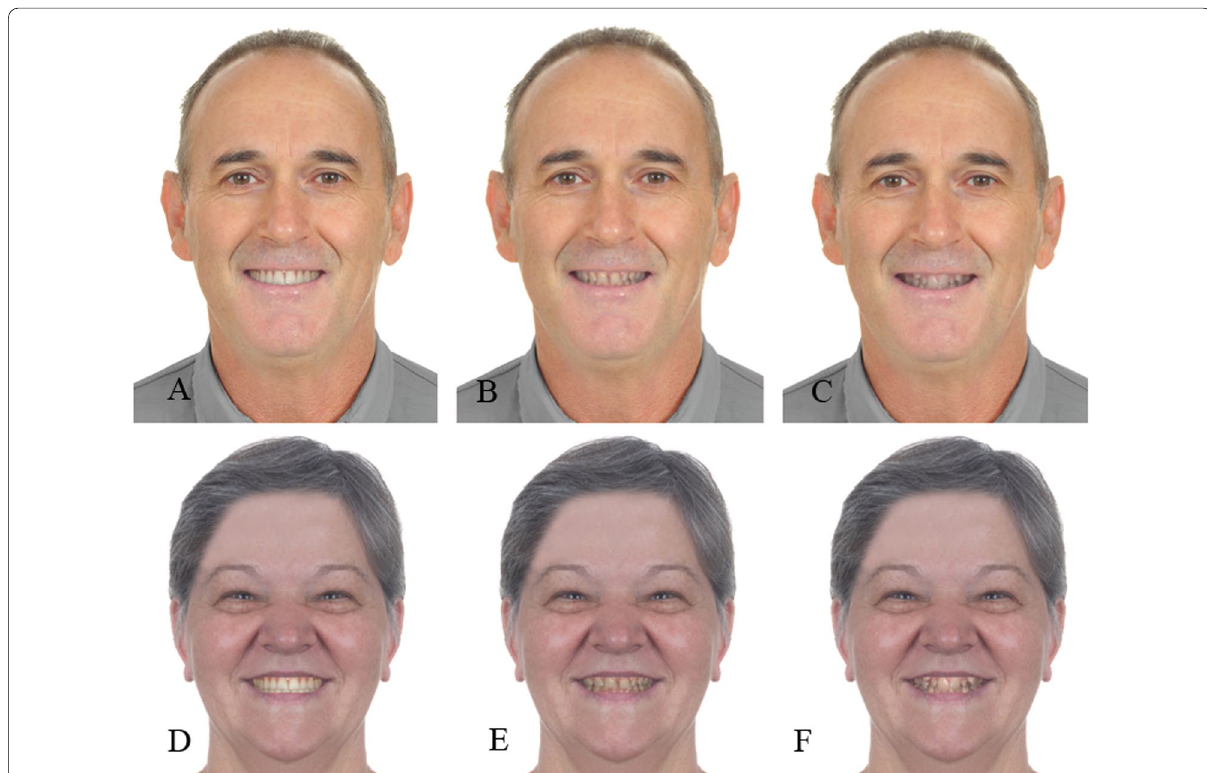
Fig. 1 IOTN’s male and female ( A , D ). IOTN grades 1 (attractive without treatment), ( B , E ). 5 (reasonable, with diastemas and teeth not aligned and leveled); ( C , F ). 8 (non-attractive, with severe